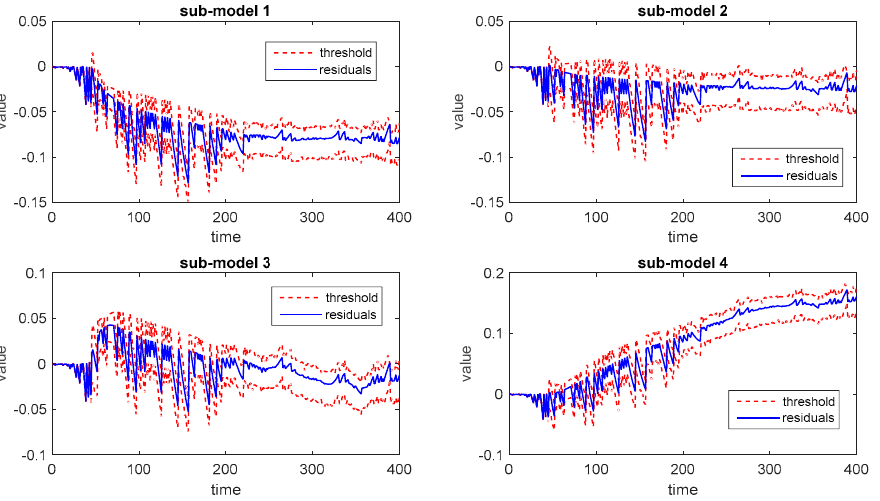
Figure 9. Monitoring results of the normal batch in penicillin fermentation case.